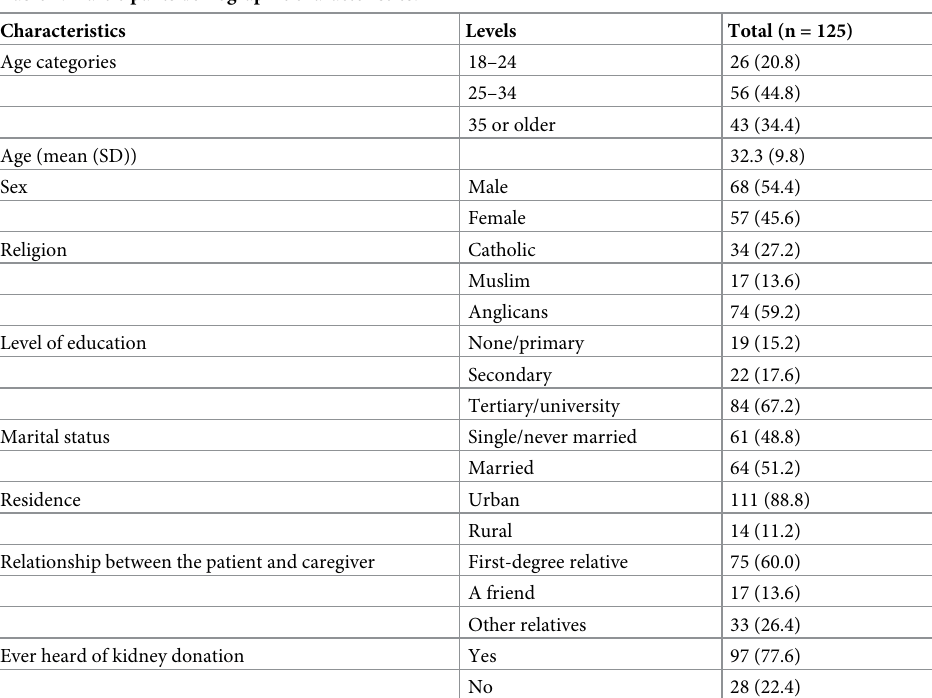
Table 1. Participants demographic